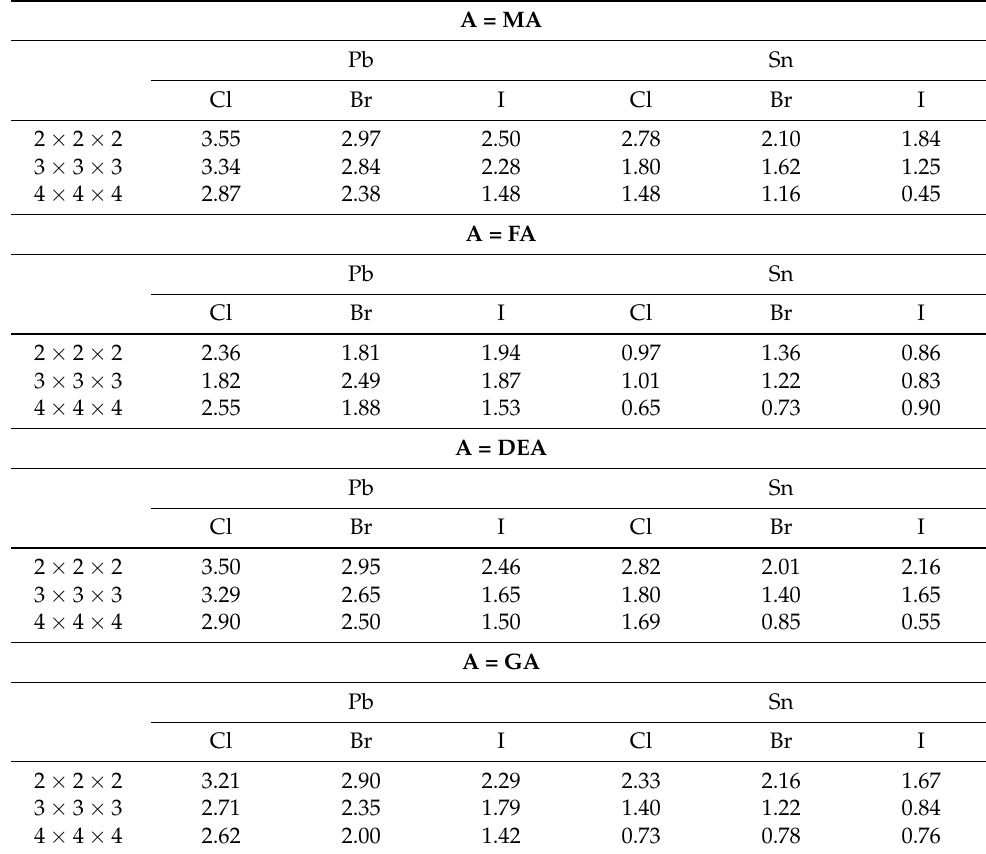
Table 1. HOMO-LUMO gap in eV for all nanoparticles under study. A = MA Pb Sn Cl Br I Cl